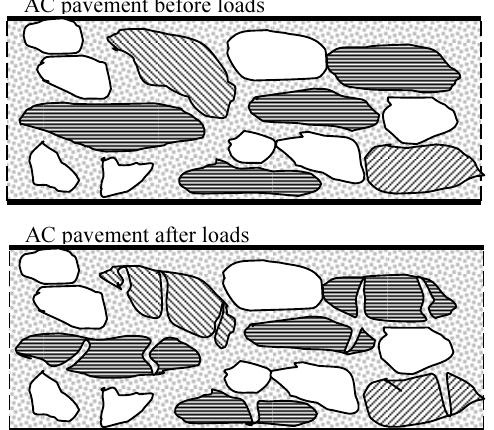
Fig. 1. How aggregate particles break and crumble, while the asphalt layer is influenced by external factors